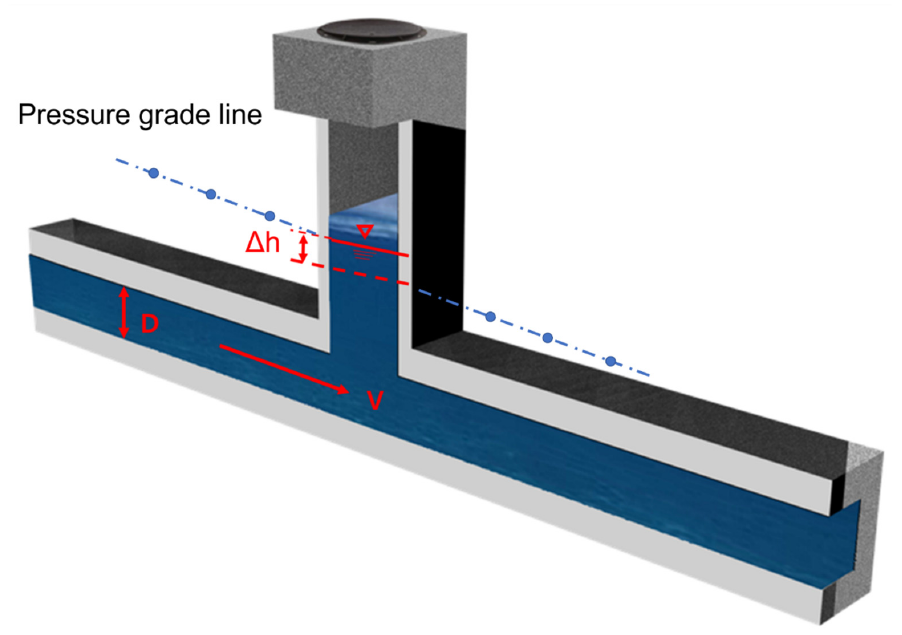
Figure 1. Head Loss at Manhole.